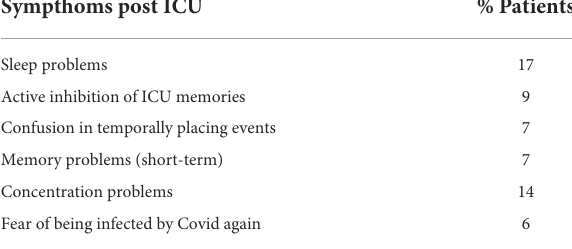
TABLE 1 Frequency of behavioral symptoms recorded during the clinical interviews at time point 1.